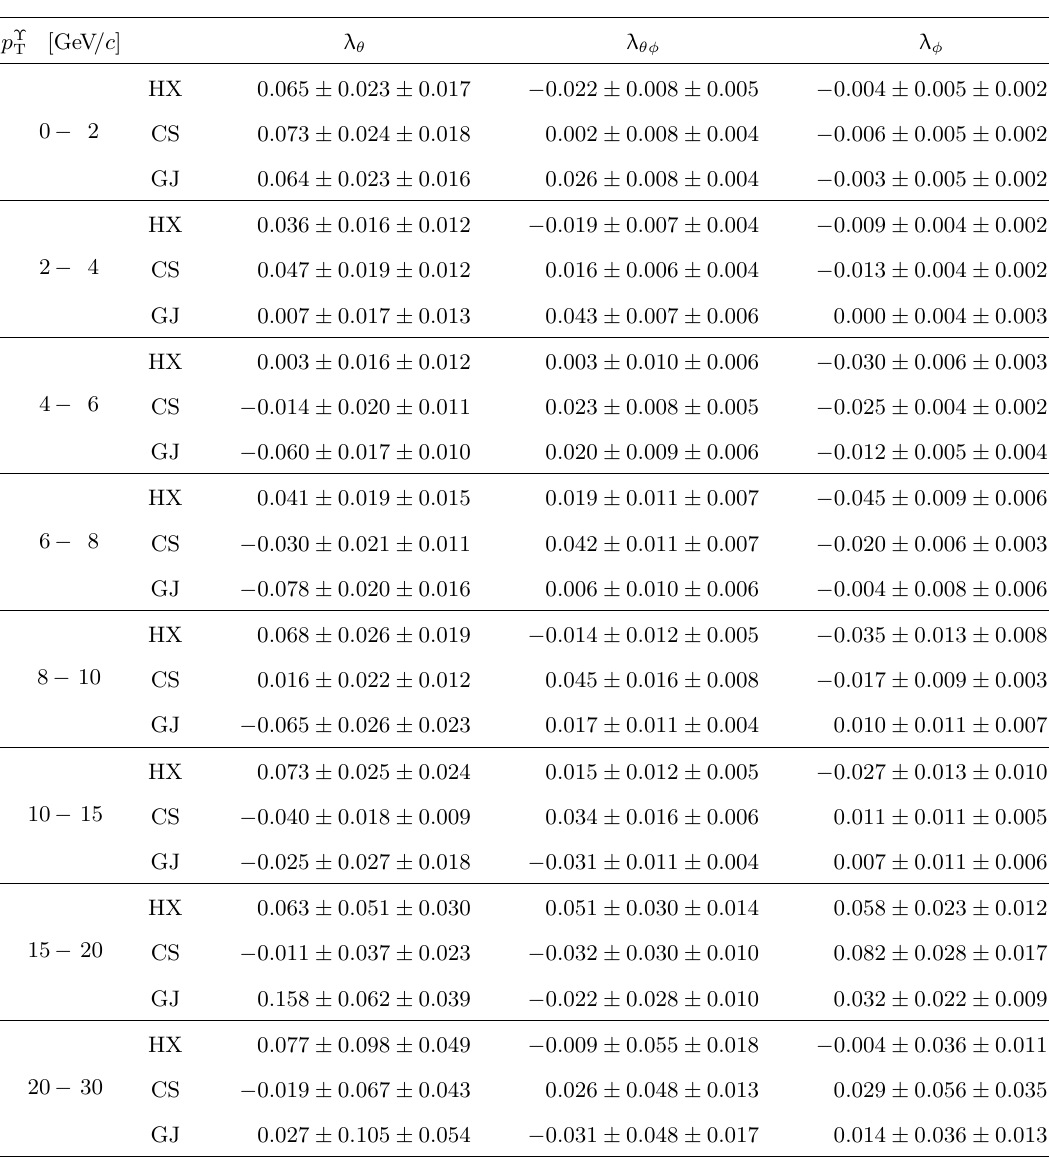
Table 8 . Values of (cid:21) (cid:18) , (cid:21) (cid:18)(cid:30) and (cid:21) (cid:30) measured in the HX, CS and GJ frames for the (cid:7)(1S) produced p at s = 7 TeV in the rapidity range 2 : 2 < y (cid:7) < 4 : 5. The (cid:12)rst uncertainty is statistical and the second